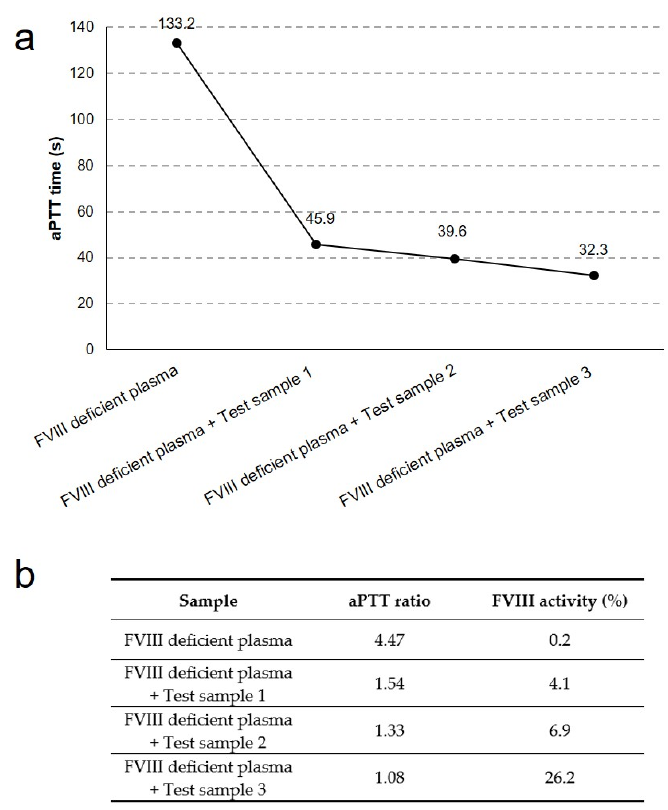
Figure 6. Coagulation assay. ( a ) aPTT reduction after mixing FVIII deficient plasma with culture medium collected from undifferentiated cells (Test sample 1) or Ad-MSCs stimulated with endothelial medium for 7 (Test sample 2), 14 (Test sample 3), and 21 days (Test sample 4). ( b ) Results of the aPTT assay reported as aPTT ratio and FVIII activity.